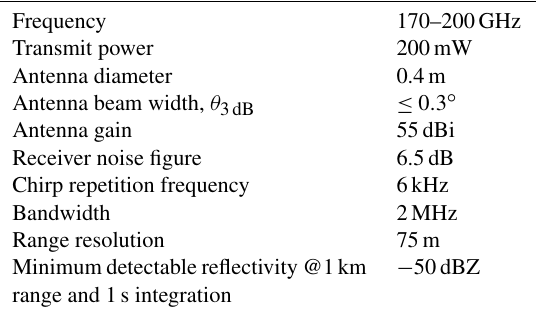
Table 2. Specifics of the frequency-modulated continuous wave radar based on W-band power amplifier and GaAs Schottky diode frequency multiplication (Nils et al., 2017) for the ground-based simulation (Peter Huggard, personal communication,